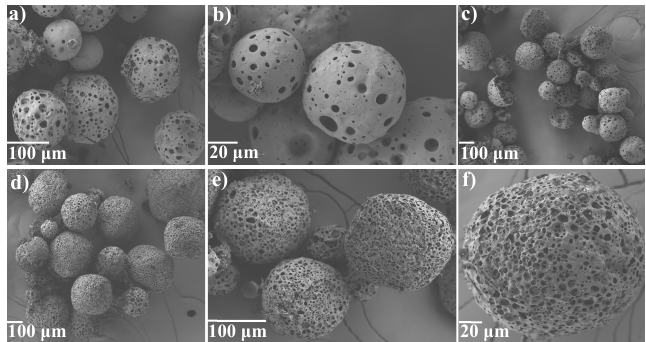
Figure 1. Representative SEM micrographs for low exendin-4 loaded PLGA 75:25 microspheres shown in ( a – c ), and high exendin-4 loaded PLGA 75:25 microspheres shown in ( d – f